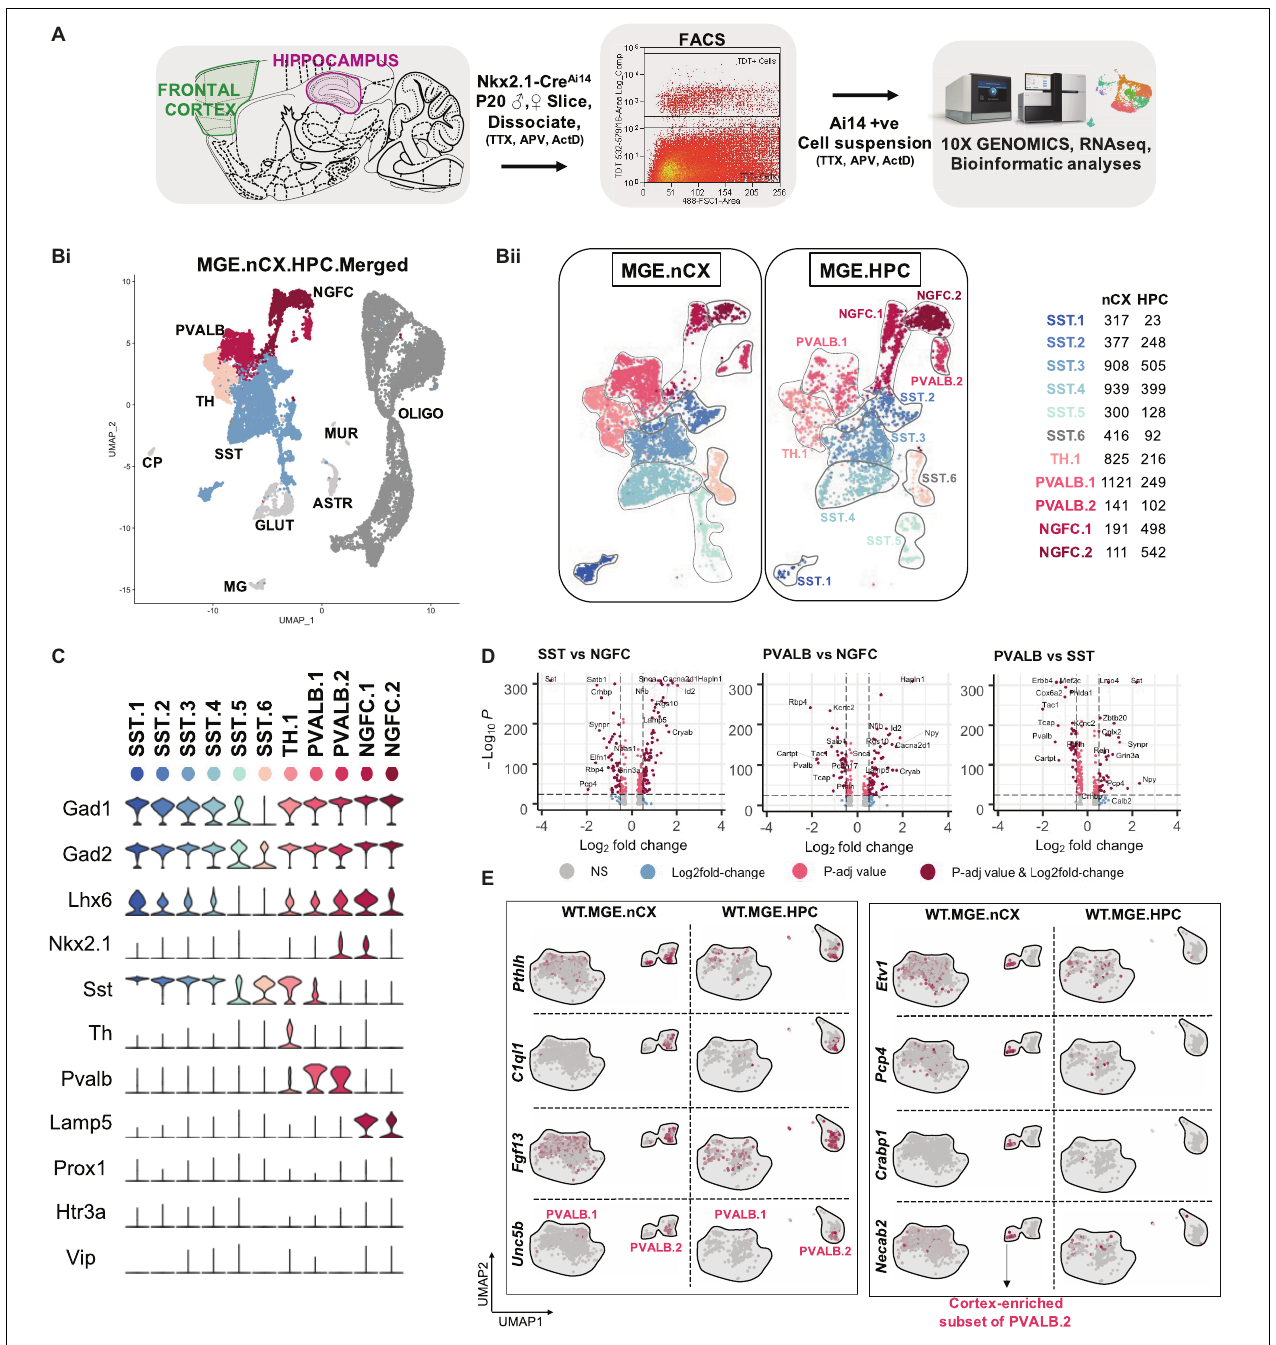
FIGURE 1 | Identification of MGE-derived interneuron subtypes in the cortex and hippocampus. (A) Overview of the experimental workflow. (Bi) Uniform Manifold Approximation and Projection (UMAP) dimensional reduction of 19,028 single-cell transcriptomes (9,064 from frontal cortex and 9,964 from hippocampus of 6 mouse brains, 3 biological replicates), showing the cardinal MGE populations. Cell clusters were color coded and annotated post hoc based on their transcriptional profile identities (Cell type abbreviations: PVALB, Parvalbumin; NGFC, Neurogliaform; TH, Tyrosine Hydroxylase; SST, Somatostatin; GLUT, Glutamatergic; CP, Choroid Plexus; MG, Microglia; ASTR, Astrocyte; MUR, Mural; OLIGO, Oligodendrocyte). (Bii) UMAP visualization of 11 MGE-derived interneuron subtypes from neocortex (MGE.nCX) and hippocampus (MGE.HPC), and the recovery of cell numbers from the subtypes. (Biii) Table indicating the number of Gad1/Gad2 + cells recovered in each MGE subtype from the neocortex and hippocampus, and the defining genes enriched in each subtype. (C) Violin plot showing the distribution of expression levels of well-known representative cell-type-enriched marker genes across the11 MGE subtypes. (D) –log10 False Discovery Rate (FDR) vs. log2 fold change (FC) between each of the MGE cardinal class, representing the top enriched markers at a fold change ≥ 0.5 and FDR < 10e-25. (E) UMAP representation of PVALB clusters highlighting the cortex-specific enrichment of Pthlh -expressing PVALB.2 subtype that is not observed in the hippocampus.